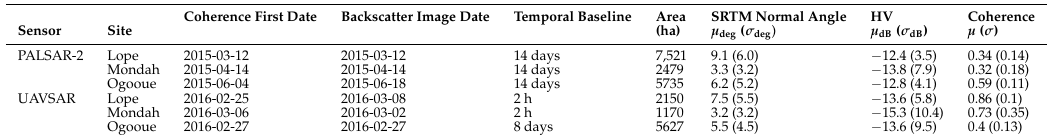
Table 2. Below, AfriSAR sites with various SAR metadata and image statistics associated over the coverage